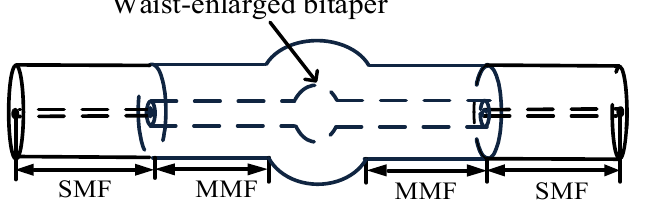
Figure 2. Schematic diagram of the Single mode–Multimode–Bitaper–Multimode–Single mode Mach–Zehnder Interferometer (SMBMS MZI).